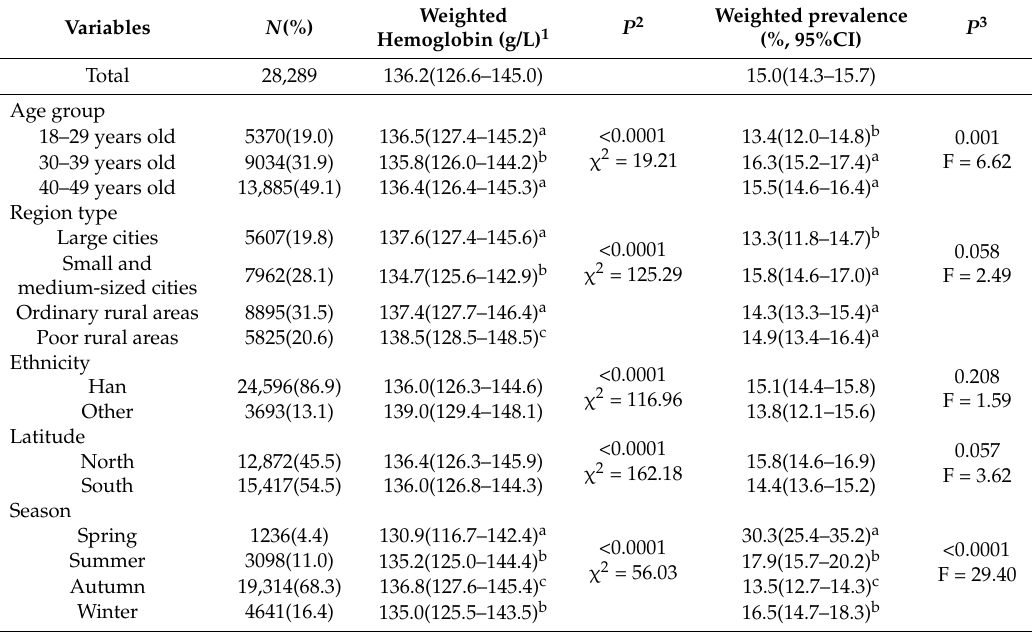
Figure 1. Survey areas distribution and its altitude (the municipal administrative units of survey area were showed. the Hong Kong Special Administrative region, Macao Special Administrative Region and Taiwan province were not included in this study. There was no survey area at altitude between 2500 and 3000 m). Table 1. Hemoglobin concentration and anemia prevalence for childbearing women from the China National Nutrition and Health Survey 2010 – 2012.